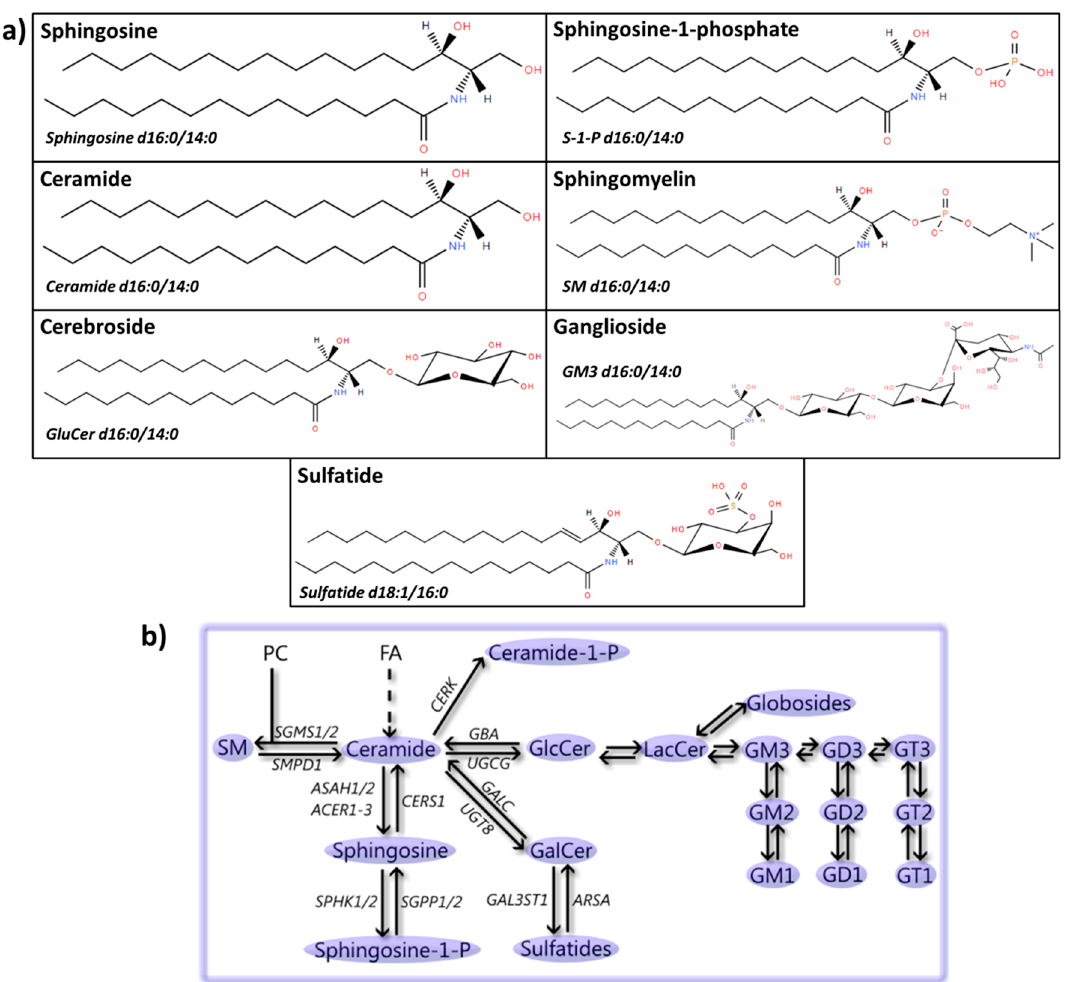
Figure 5. Sphingolipids: structures and metabolic steps involved. ( a ) Schematic representation of the chemical structures of sphingolipids, including sphingosine (d16:0/14:0), sphingosine-1-phosphate (S-1-P d16:0/14:0), ceramide (d16:0/14:0), sphingomyelin (SM d16:0/14:0), cerebroside (glucosylceramide, GluCer, d16:0/14:0), ganglioside (GM3 d16:0/14:0), and sulfatide (d18:1/16:0). Chemical structures are